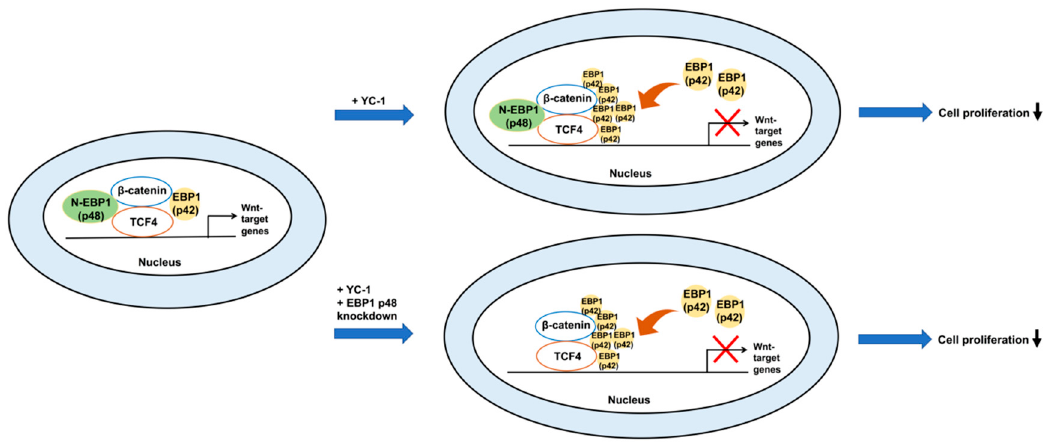
Figure 6. Schematic model of YC-1 involvement in the regulation of Wnt / β -catenin signaling and tumor cell proliferation.